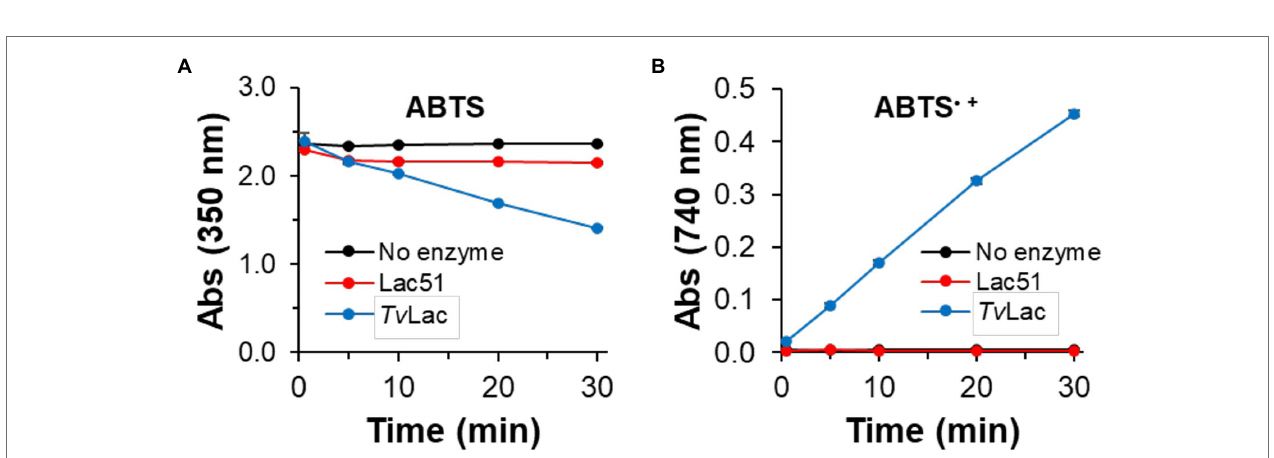
FIGURE 4 | Laccase activity using ABTS. ABTS (0.1 mM) was incubated with 0.4 μ M Lac51 (red) or 0.4 μ M Tv Lac (blue) in 50 mM Na-acetate buffer pH 5.0 at 37 ° C. The reaction was followed by detecting (A) the consumption of ABTS at 350 nm and (B) the formation of ABTS •+ radical cations at 740 nm. Error bars indicate SD of